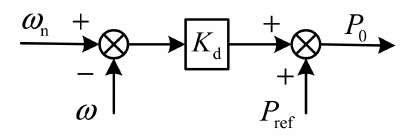
Figure 2. Structure block diagram of VSG governor control.